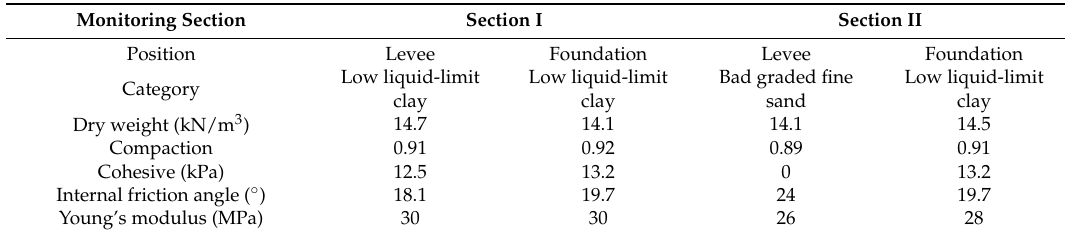
Table 4 lists the material parameter results. Table 4. Material parameters of levee body and foundation.